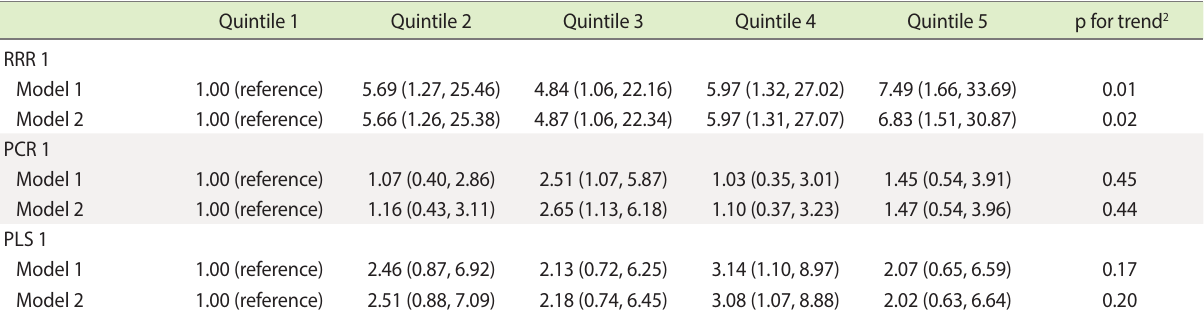
Table 3. Hazard ratios and 95% confidence intervals for stroke by 2 models 1 and 3 methods according to quintiles of the first dietary pattern score in 5,468 males and females from